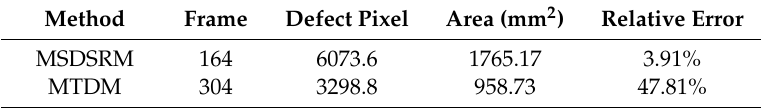
Table 6. Comparison of the results of MSDRM and MTDM for CFRP